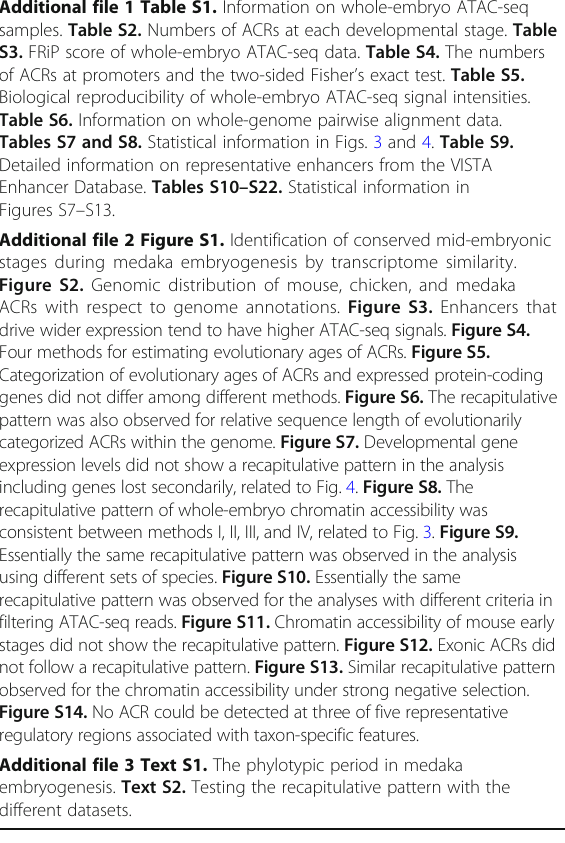
Figure S2. Genomic distribution of mouse, chicken, and medaka ACRs with respect to genome annotations. Figure S3. Enhancers